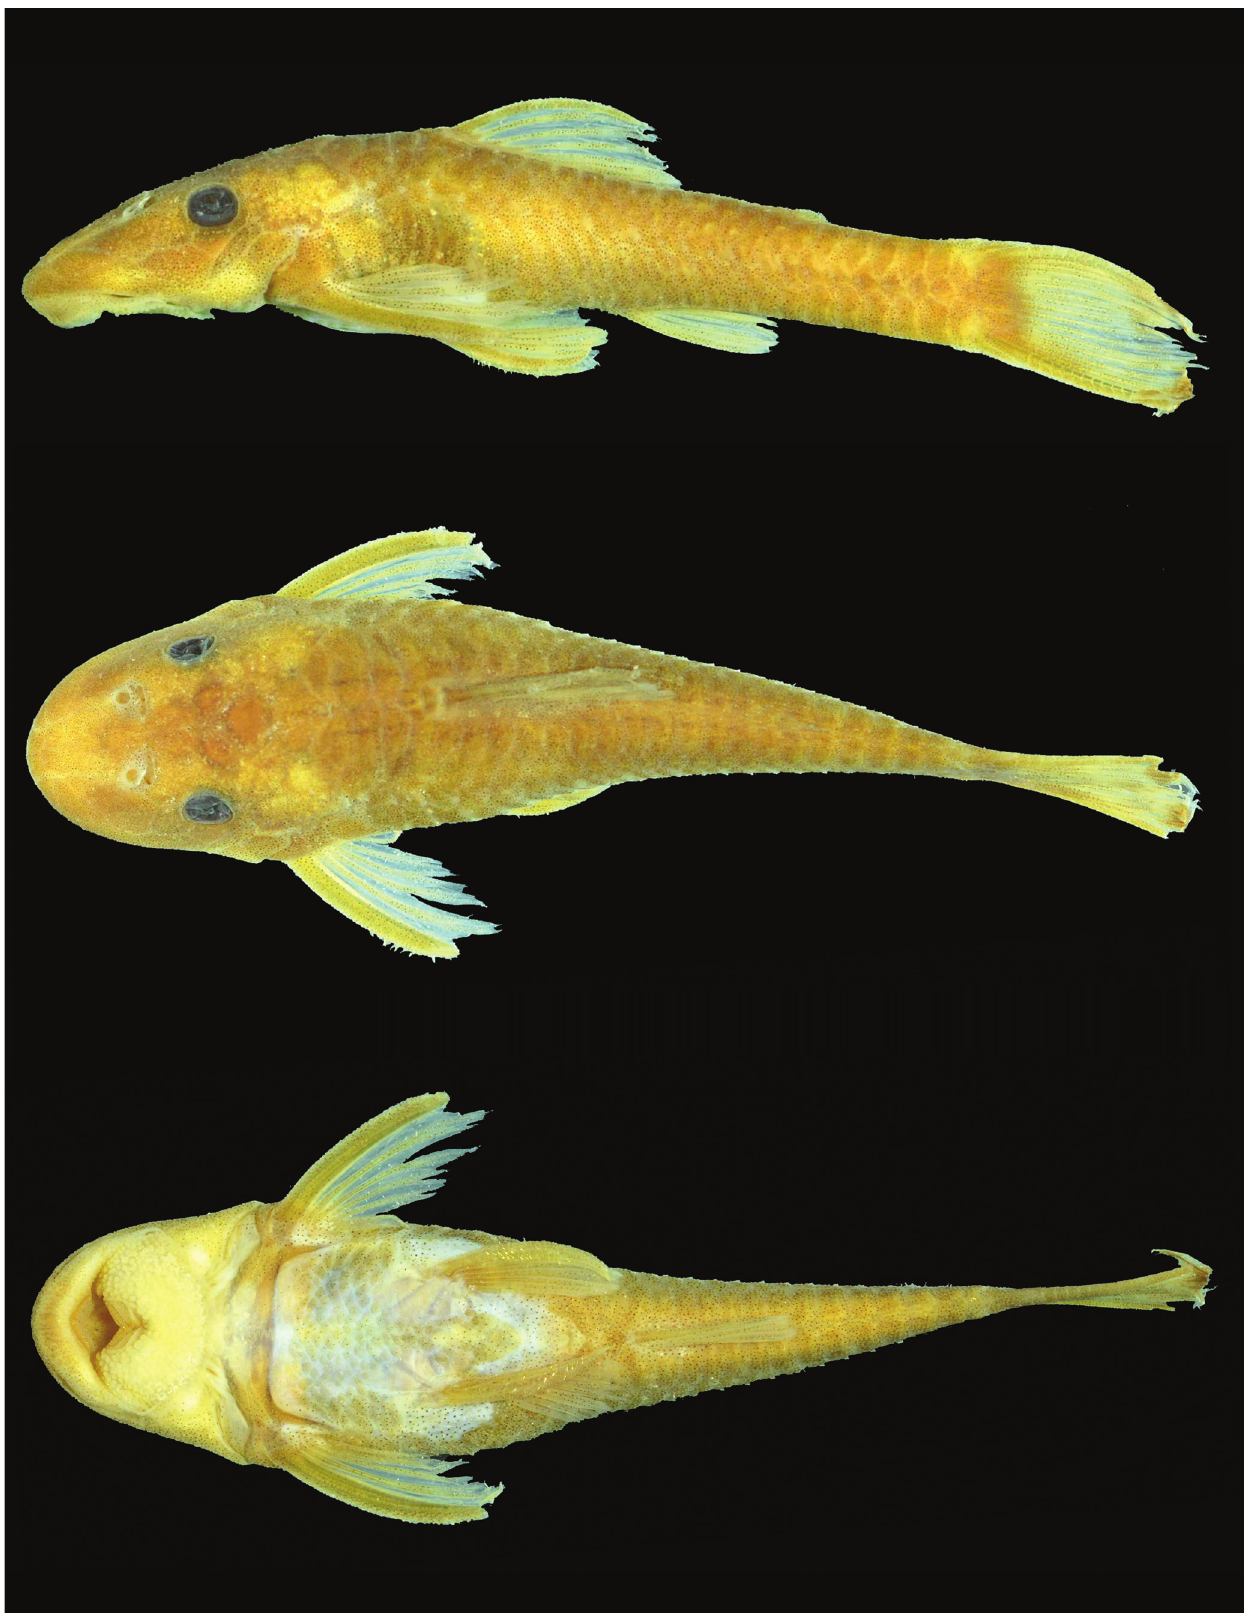
Fig. 1. Lateral, dorsal, and ventral views of Parotocinclus spilurus , holotype ANSP 69403, 28.6 mm SL female; Brazil, Ceará State, Icó Municipality, rio Salgado, rio Jaguaribe